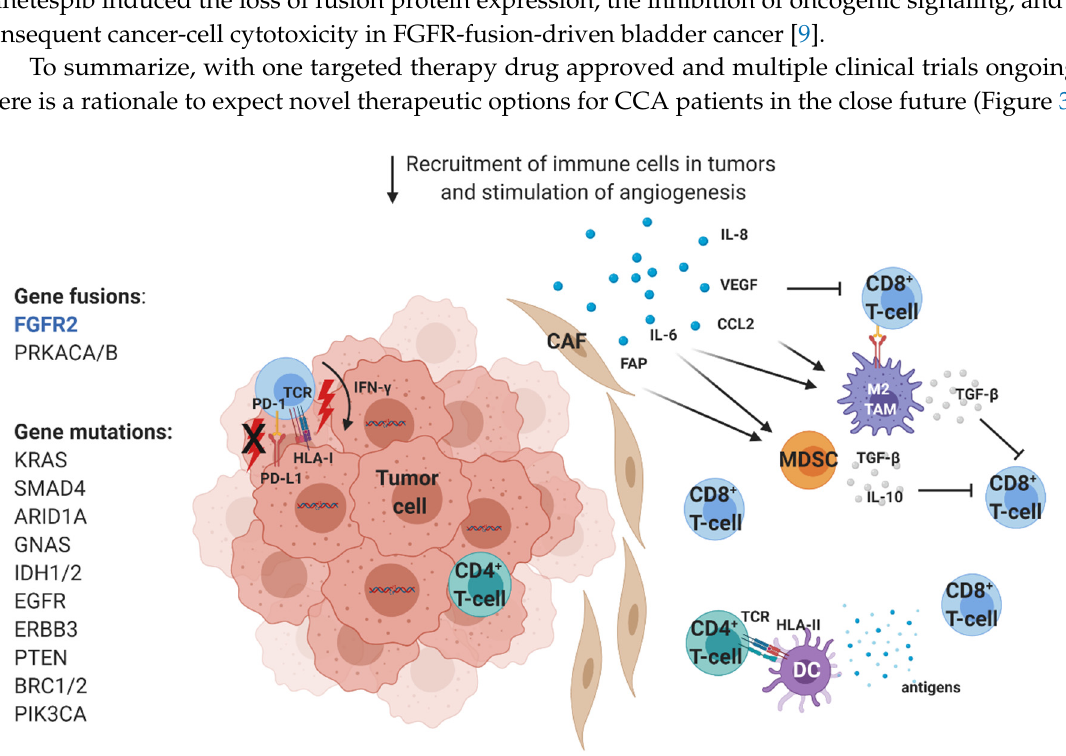
Figure 3. Molecular and immunologic characterization of BTCs. CAF: Cancer-associated fibroblast; CCL2 Chemokine (C–C motif) ligand 2; DC: Dendritic cell; FA: Fibroblast activation protein; HLA-I: Human leukocyte antigen I; HLA-II: Human leukocyte antigen II; IL-6: Interleukin 6; MDSC: Myeloid-